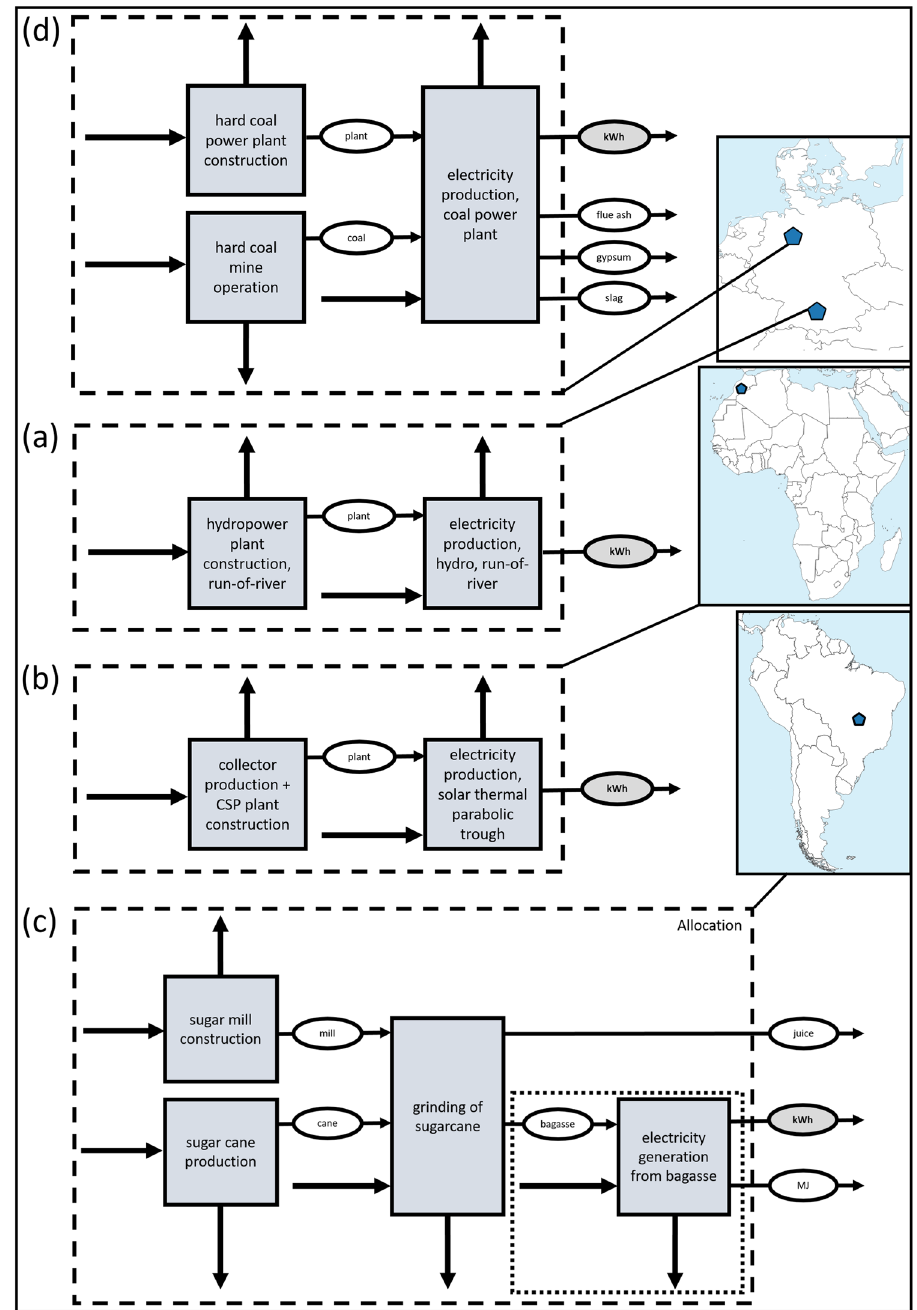
Fig. 1 Simpli fi ed LCA models and locations of the four case studies. The locations of the case studies are shown in the connected maps: a is located at the river Danube, Germany, b in Quarzazate, Morocco, c in the Rio dos Patos basin, Brazil, and d at the river Weser, Germany. For case study c , the sugar mill in Brazil, two different system boundaries are considered to account for waste-bagasse incineration (inner dotted boundary) and bagasse incineration (outer dashed boundary). Black arrows symbolise inputs and outputs, apart from the extra marked. In the fi gure, only the greatest contributions are considered in own processes (black boxes), respectively, other inputs are summarised via the black